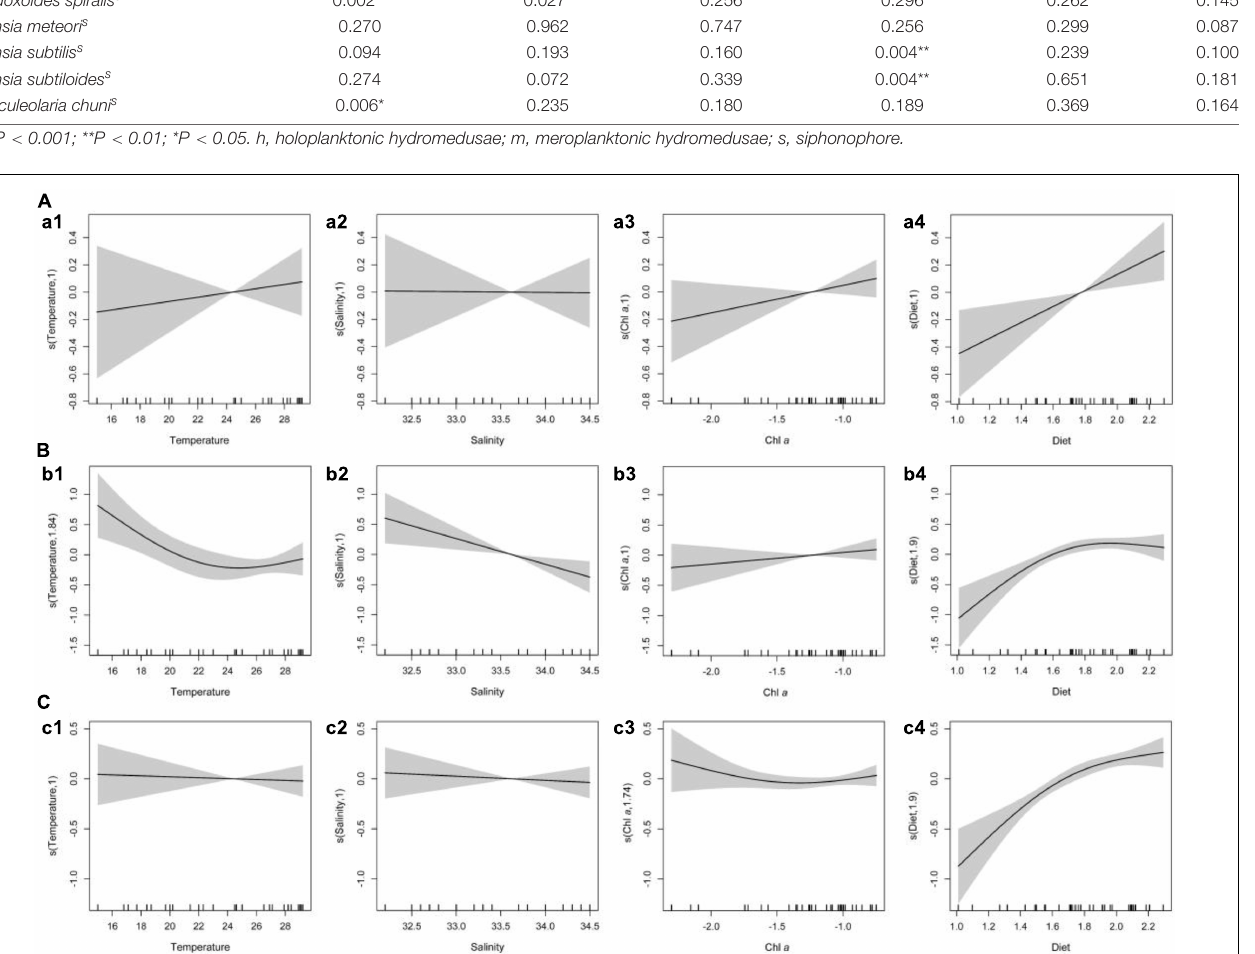
Frontiers in Marine Science |